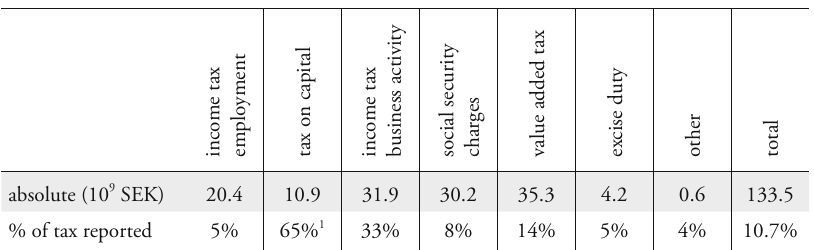
Table 4: Tax Gap by Tax Type by the Swedish Tax Authority in